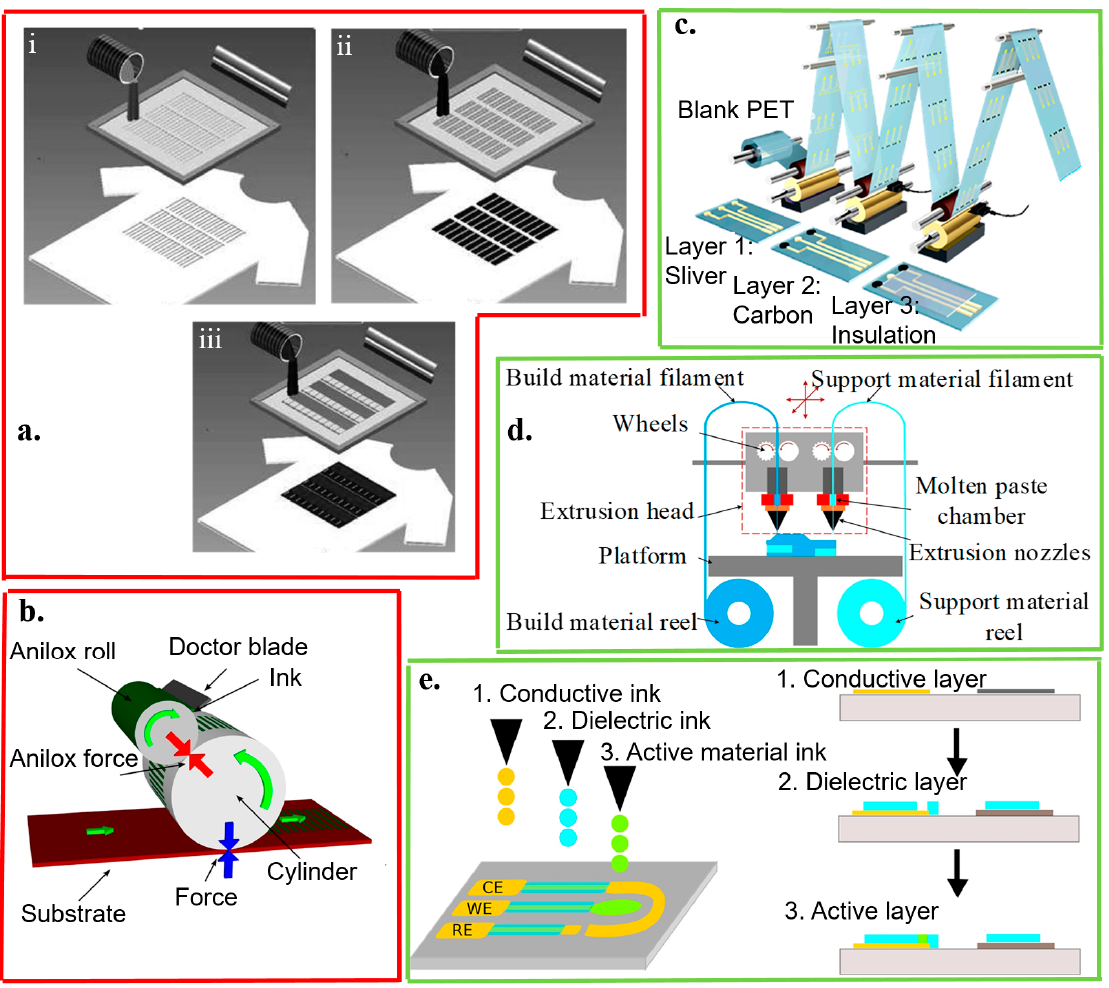
Figure 4. Template- (red boxes) and non-template (green boxes) fabrication approaches. The template fabrication approaches include ( a ) screen printing, ( b ) flexographic process, and ( c ) gravure printing. The screen printing explores (i) laser-cut stainless steel or chemically-etched polymeric mesh-screen stencils for patterning (ii) the Ag / AgCl reference and (iii) working / counter electrodes with carbon- or metal-based ink containing recognition elements overlaid on the Ag / AgCl conductor; reproduced with permission from [50], Copyright 2013, Wiley-VCH. In the flexographic process, the surface of the anilox roller consists of engraved cells. The doctor blade helps to remove excess ink from the anilox; reproduced with permission from [112], Copyright 2017, Elsevier. By using a rotary printing press in the gravure printing, the image is engraved onto a cylinder; reproduced with permission from [113], Copyright 2018, American Chemical Society. The non-template fabrication approaches include ( d ) 3D printing and ( e ) inkjet printing. In extrusion-based 3D printing, the build material filament is heated, melted, and extruded in the nozzle. Each layer is deposited on the previous layer to form the designed 3D structure; reproduced with permission from [114], Copyright 2016, Wiley-VCH. In inkjet printing, layers of conducting and dielectric materials are injected, patterned, and stacked on a substrate; reproduced with permission from [115], Copyright 2015,